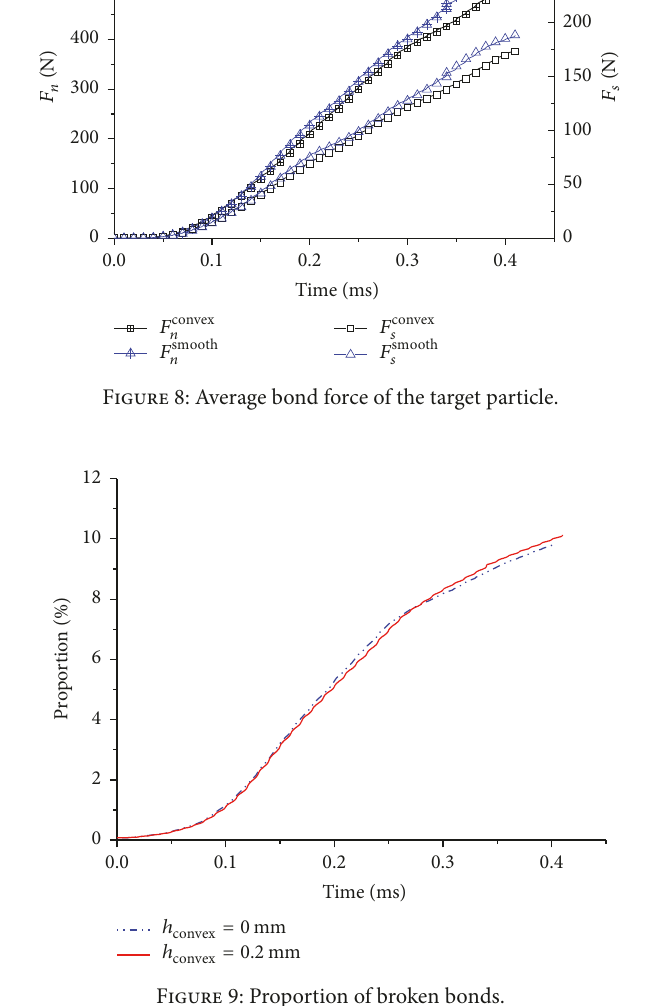
Figure 9: Proportion of broken bonds.